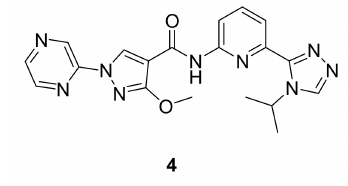
Figure 11. Structure of compound 4